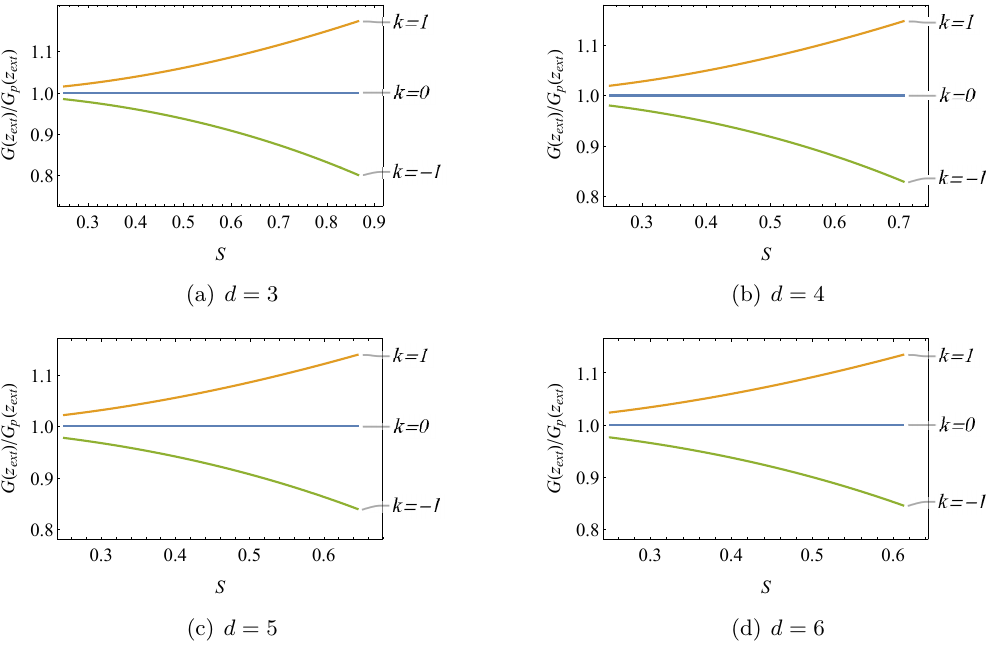
Figure 6 . For ‘ AdS = 1 , the vertical axis represents G ( z ext ) /Gp ( z ext ) and the horizontal axis represents S